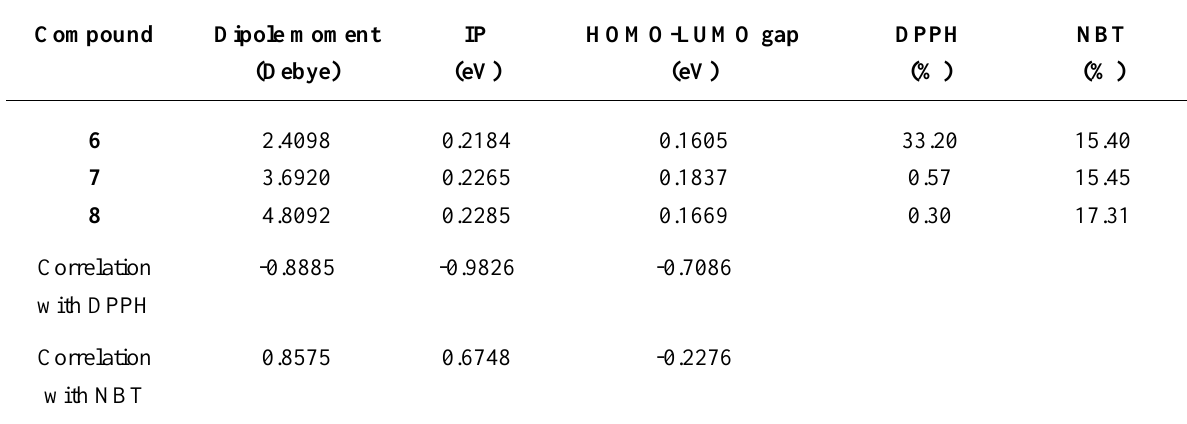
Table 6. Calculated molecular descriptors derived from B3LYP/6-31g(d) as correlated with the antioxidative